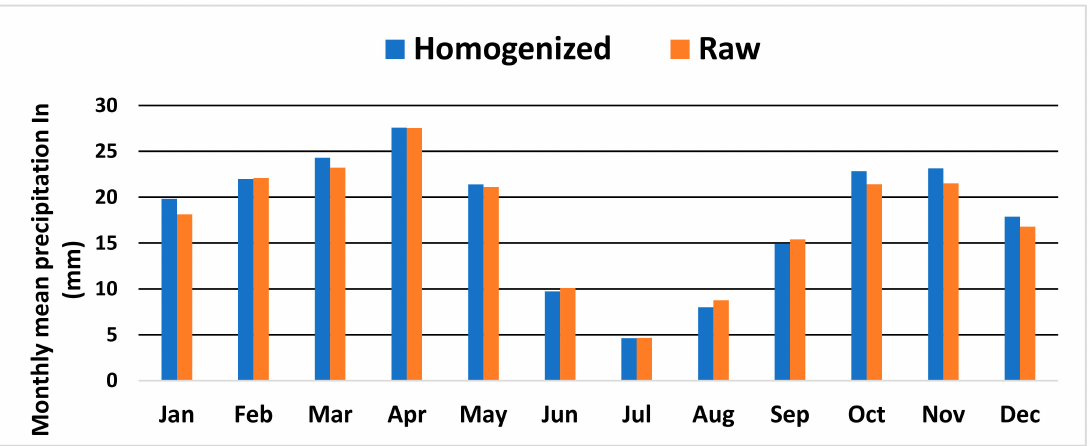
Figure 11. Monthly averages of raw and homogenized data for the arid zone beyond the mountainous